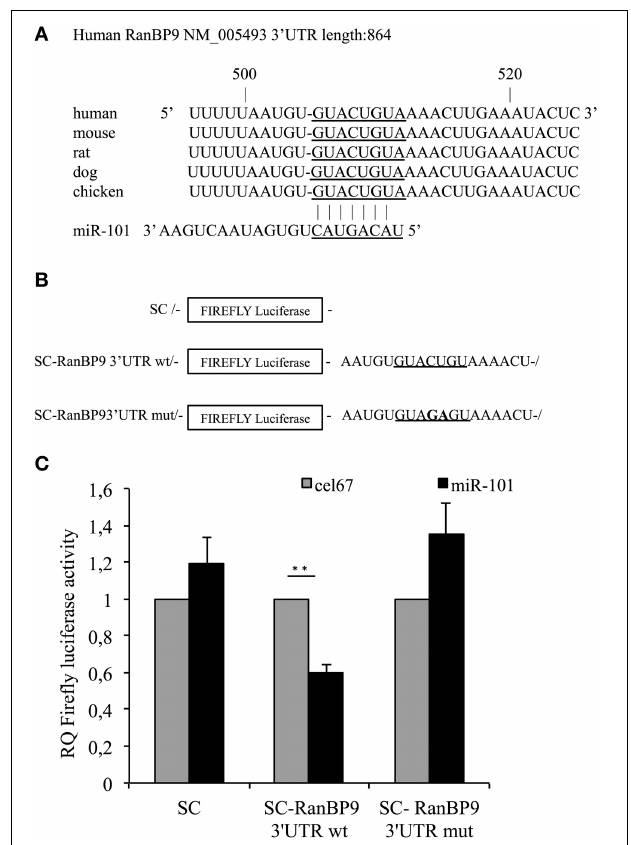
FIGURE 1 | The conserved miR-101 target site at the 507–513bp region of the RanBP9 3 (cid:2) UTR is necessary for RanBP9 post-transcriptional regulation. (A) Ribonucleotide sequences of the conserved putative miR-101 RE within the RanBP9 3 (cid:2) UTR paired with the mature miR-101 sequence. (B) Schematic representation of the luciferase constructs used in this study. The miR-101 RE within the RanBP9 3 (cid:2) -UTR is underlined. In the mutant construct, the nucleotides at positions 4 and 5 of the miR-101 RE were mutated, as indicated in bold font. (C) SH-SY5Y neuroblastoma cells were transfected independently with the SC control plasmid or with each of two SC-RanBP9 luciferase reporter genes together with either miR-101 or a control microRNA (cel-miR-67) (100nM). At 24h post-transfection, luciferase activity was determined. Results are presented as the normalized activity of miR-101-transfected cells relative to that of cells transfected with cel-miR-67. Data are presented as the means ± the SE from three or four independent experiments ( ∗∗ p < 0 . 01, Student’s t -test).